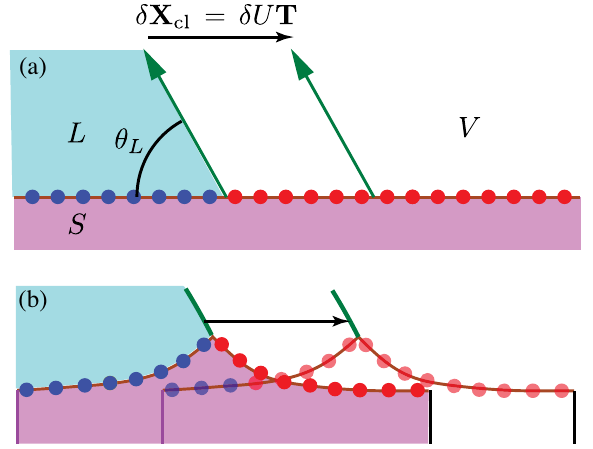
FIG. 6. Determining the liquid contact angle θ upon global L displacement of the solution. (a) Lagrangian point of view: On the domain of material coordinates, the shift is achieved by a ¼ δ U T , where the contact line change of material point δ X cl applies. Without pinning, the displacement is energetically neutral, while, in the presence of a pinning defect, an energy − Γ δ U is dissipated at the contact line. (b) Eulerian point of view: The displacement δ U leads to a variation of the entire solution as given in Eq. (34). At a large distance from the contact line, the − γ Þ λ δ U change of the surface energies reads ð γ ∞ SL SV